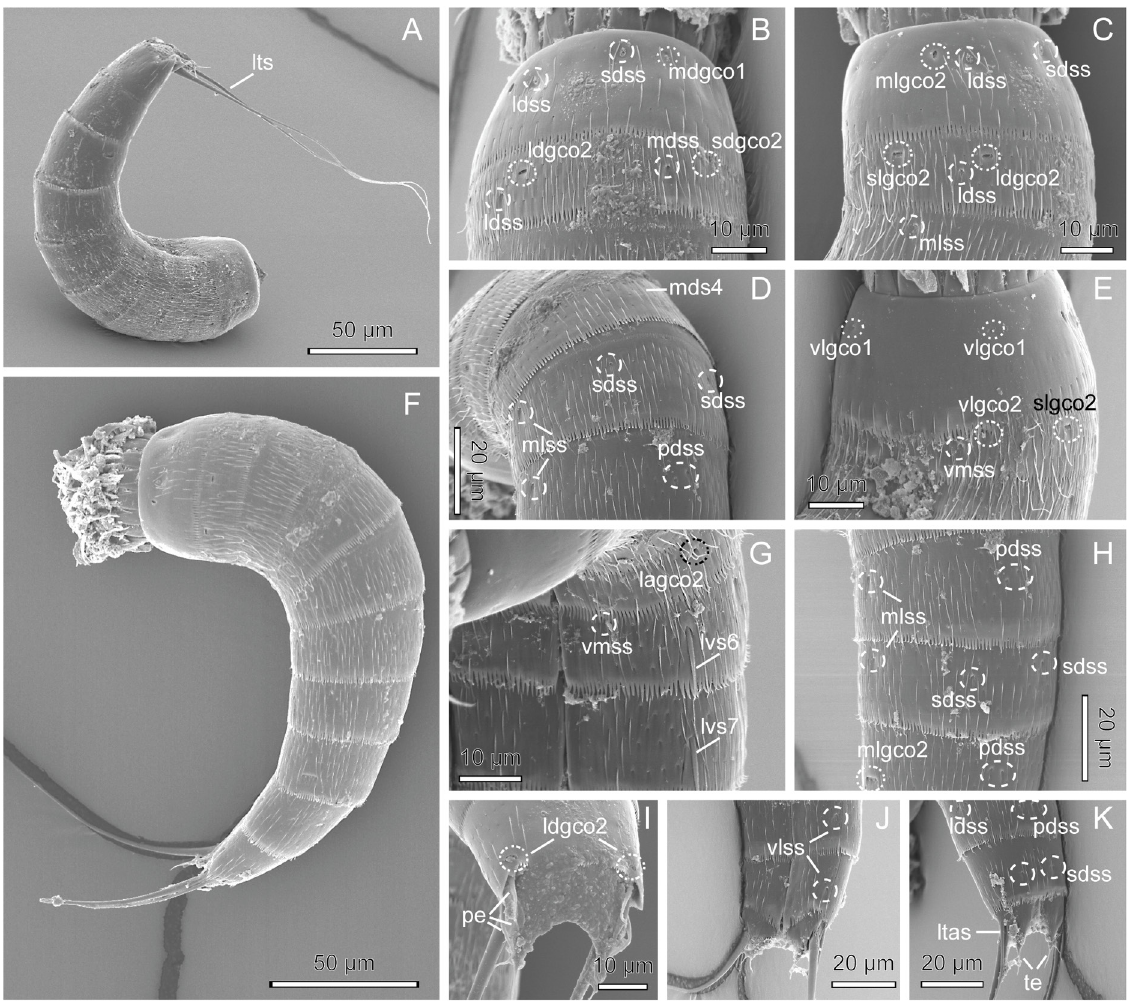
Fig. 37. Scanning electron micrographs showing overviews and details of Echinoderes sp. aff. E. unispinosus . A . Lateral overview. B . Segments 1 to 3, subdorsal view. C . Segments 1 to 3, lateral view. D . Segments 4 to 6, subdorsal view. E . Segments 1 to 3, lateroventral view. F . Lateral overview. G . Segments 5 to 7, lateroventral view. H . Segments 6 to 8, laterodorsal view. I . Segments 10 to 11 of male, dorsal view. J . Segments 9 to 11, ventrolateral view. K . Segments 9 to 11 of female, laterodorsal view. Abbreviations: see Material